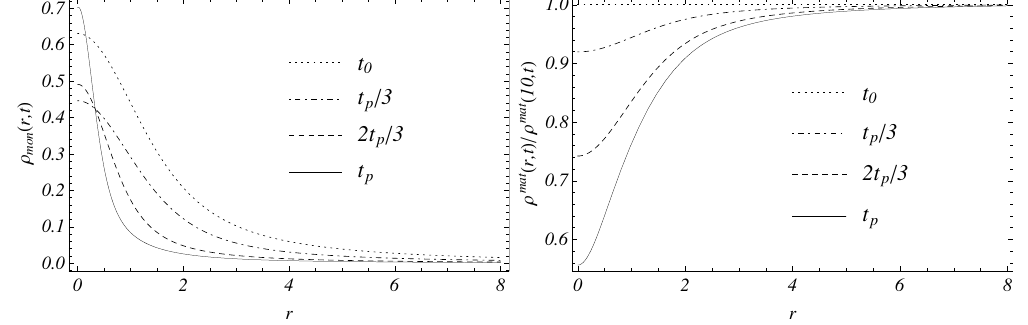
Figure 6. Evolution of the dark energy (left panel) and properly normalized matter (right panel) density profiles.The profiles shown correspond to the initial time t (dotted line), 0 t / 3 (dot-dashed line), 2 t / 3 (dashed line), t (solid line, present time). Notice the matter p p p underdensity that develops in the monopole core while the monopole density appears to slowly collapse to the center in comoving coordinates. The radial unit is the monopole core size δ (from